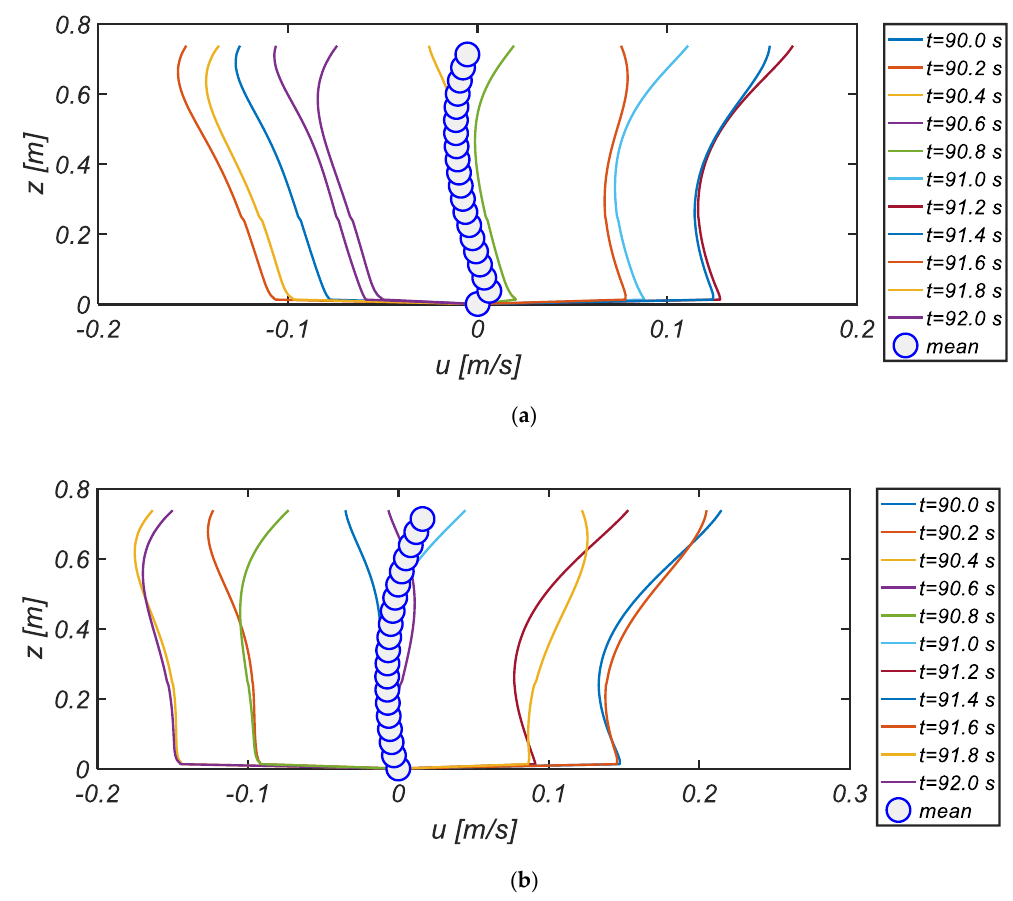
Figure 8. Comparison of the vertical profiles of horizontal velocity at x = 6.0 m during unit wave period by varying wave height. ( a ) RUN 1; ( b ) RUN 2.